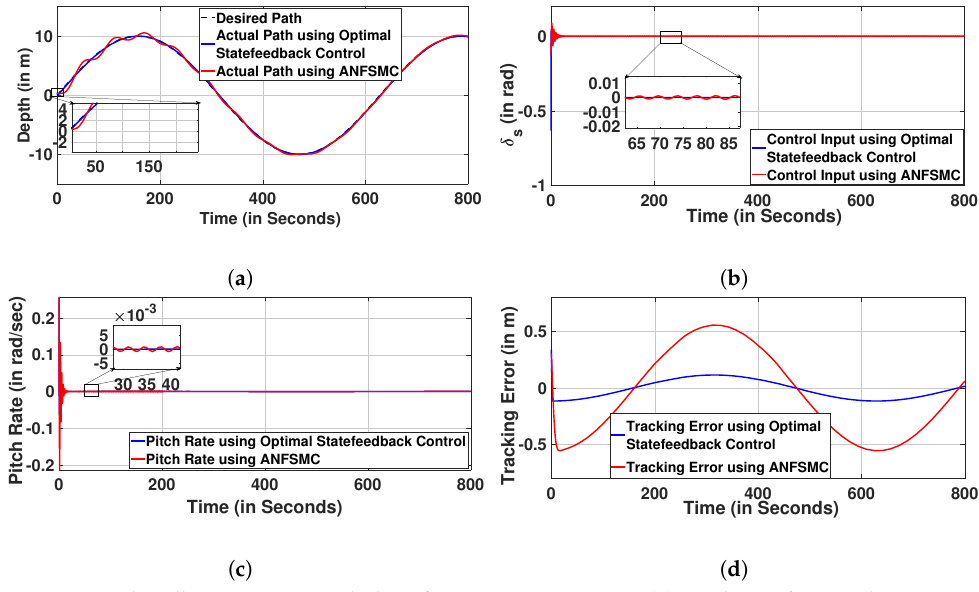
Figure 6. Path Following in Vertical Plane for ± 10% Uncertainty. ( a ) Tracking of Desired Sine Wave, ( b ) Control Input for a Sine wave, ( c ) Pitch Rate for a Sine Wave, ( d ) Error Signal for a Sine